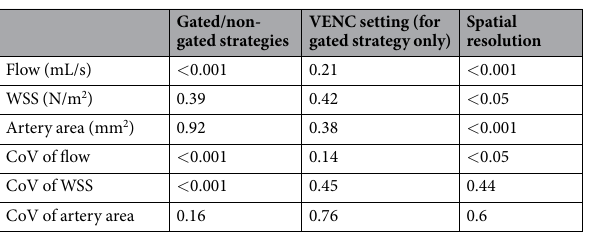
Table 1. The summary of P values of the hemodynamic measurements from both Study 1 and Study